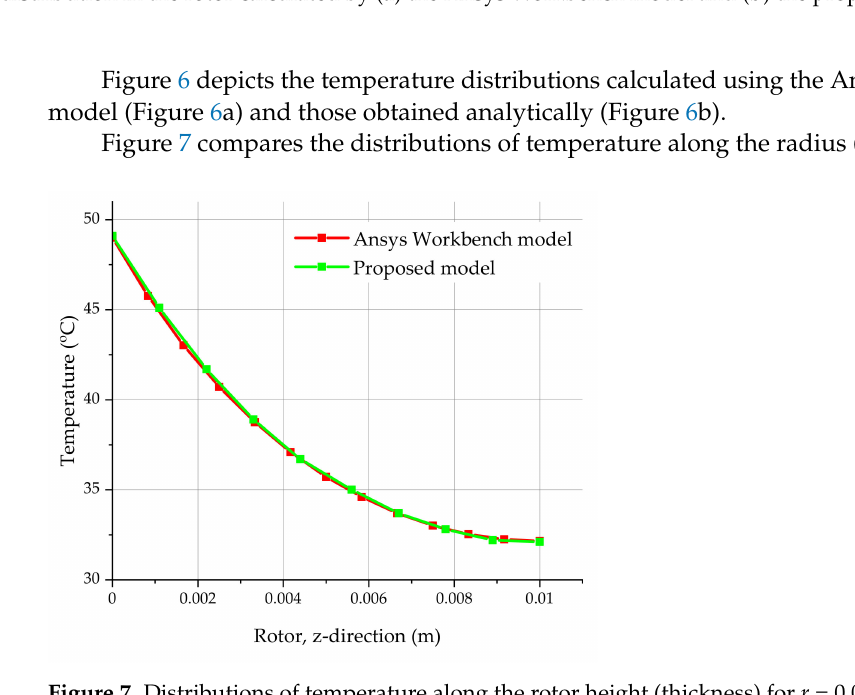
Figure 7. Distributions of temperature along the rotor height (thickness) for r = 0.0525